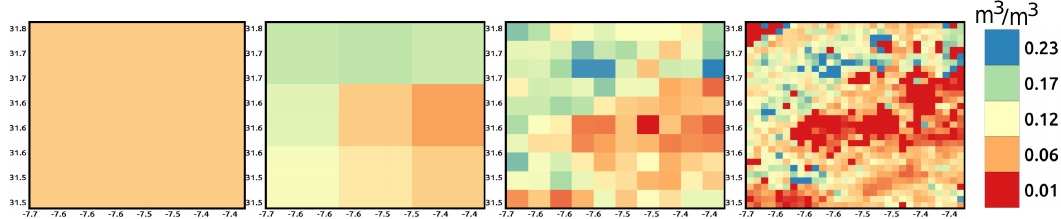
Figure 8. SM p parameter images derived from SMAP data on DOY 38 for ISR equal to 30 km, 10 km, 3 km and 1 km from left to right,